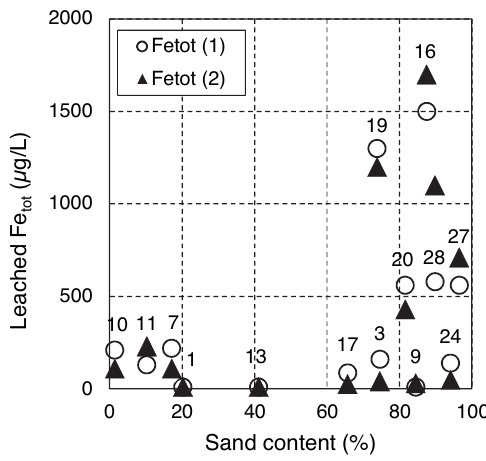
Fig. 9. The leached Fe tot concentrations versus sand content of rocks. Fe tot (1), concentrations after 2 days of leaching; Fe tot (2), concentrations after 14 days of leaching. The numbering of the rock samples is in accordance with Table